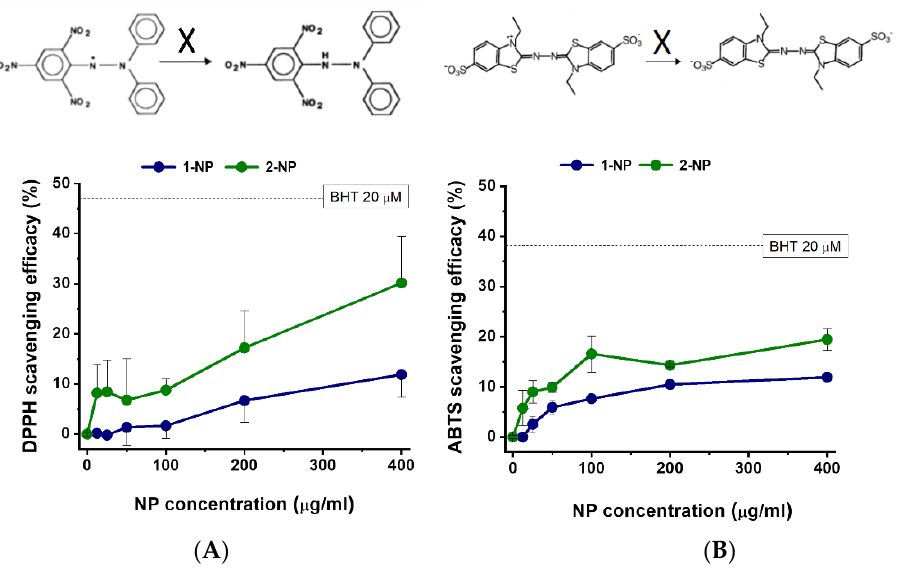
Figure 2. Organic radical scavenging efficacies of F127@ 1 -NP and F127@ 2 -NP. The indicated con- centrations of NPs were incubated with DPPH ( A ) and ABTS ( B ) and the % neutralization (see top schemes) was estimated spectroscopically after 30 min incubation at 37 °C. Data are means ± SE (N = 4). The scavenging effect of BHT is indicated in the graphs for comparison.